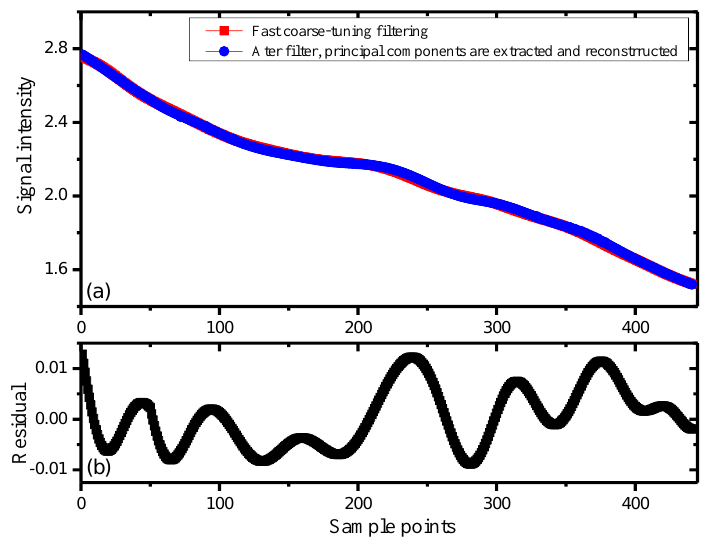
Figure 4. Extraction and reconstruction of the main feature information. ( a ) Signals before and after the extraction and reconstruction of the main feature information; ( b ) Residual.